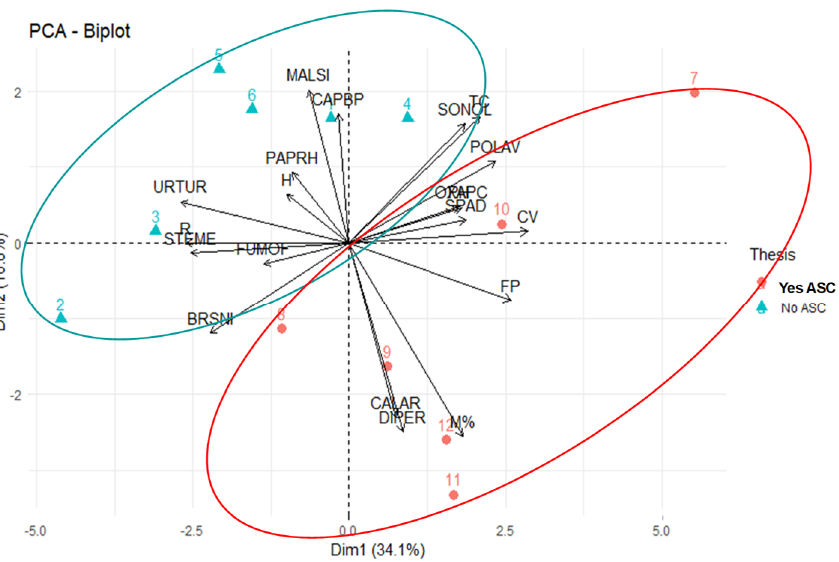
Figure 7. PCA biplot and confidence ellipses ordering the organic orange tree experimental trial relative to main weed species cover (%), frequency (%) of Polygonum aviculare (POLAV), Calendula arvensis (Vaill.) (CALAR), Diplotaxis erucoides (DIPER), Brassica nigra (BRNSI), Stellaria media (STEME), Urtica urens L. (URTUR) and Malva sylvestris L. (MALSI), Shannon–Weaver index (H), specie Richness (R), orange root mycorrhizal colonization intensity (M%), foliar SPAD and P content (FP, g kg − 1 ), plant height (PH), trunk circumference (TC) and canopy volume (CV) at the April sampling time. No ASC: fallow. Yes ASC: